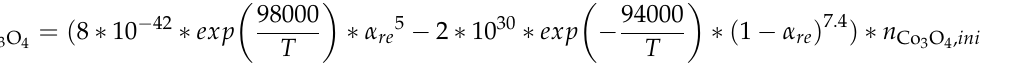
Table 4. Results of kinetic triplet solution. Reaction Process 𝐀 / 𝐬 (cid:2879)𝟏 𝐄 /( 𝐉/𝐦𝐨𝐥 )